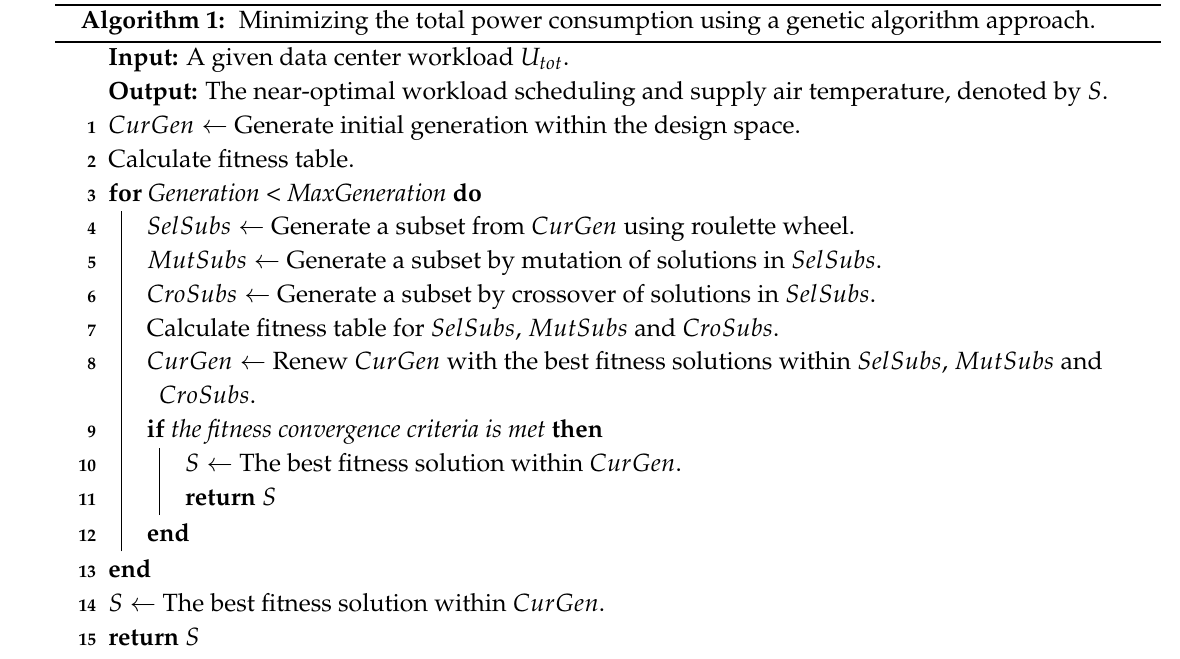
Algorithm 1: Minimizing the total power consumption using a genetic algorithm